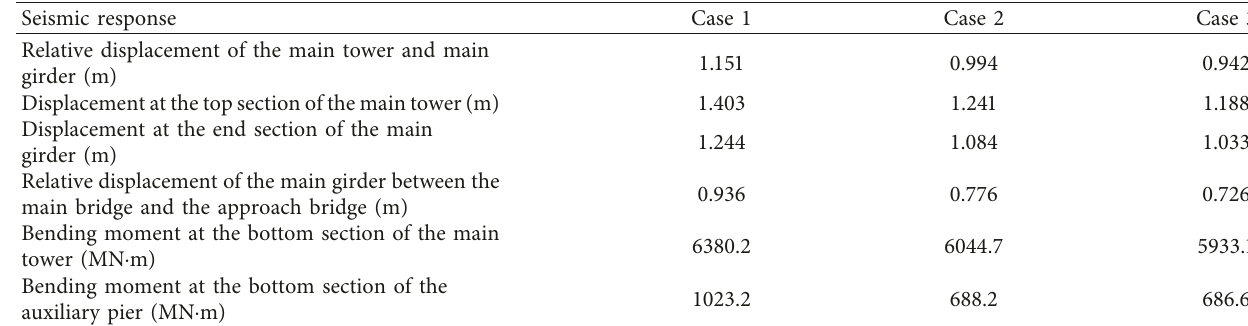
Table 4: Structural seismic longitudinal response results of the three